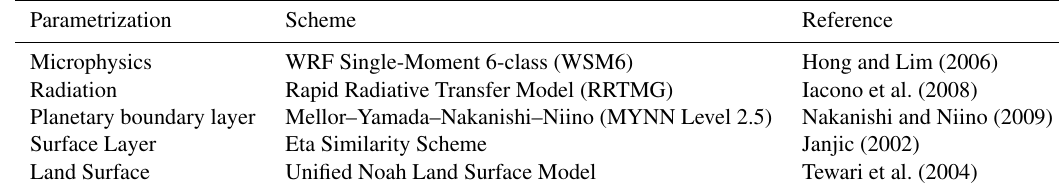
Table 1. Summary of physical parameterizations used in both